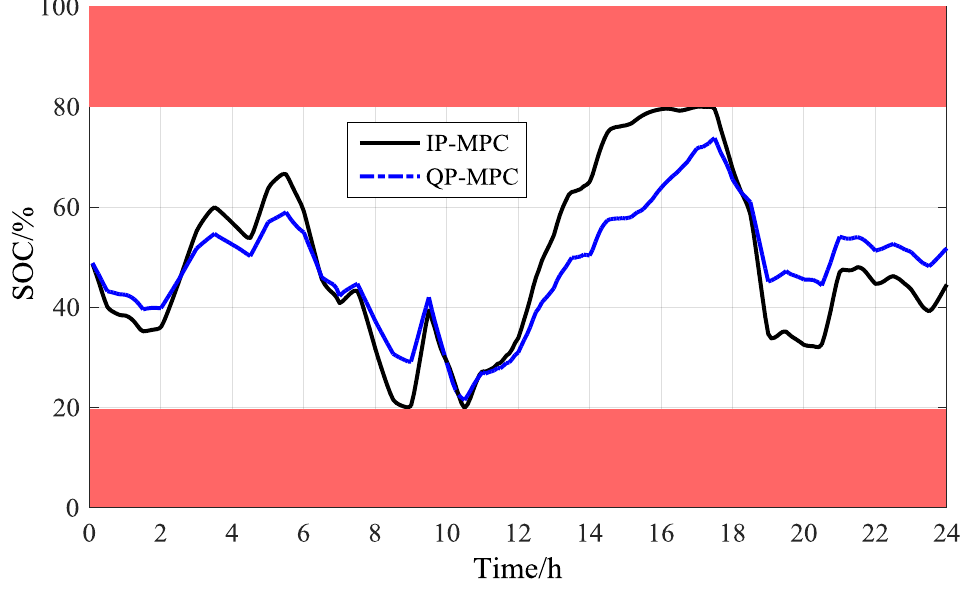
Figure 7. SOC of BESS (4.5 MWh).